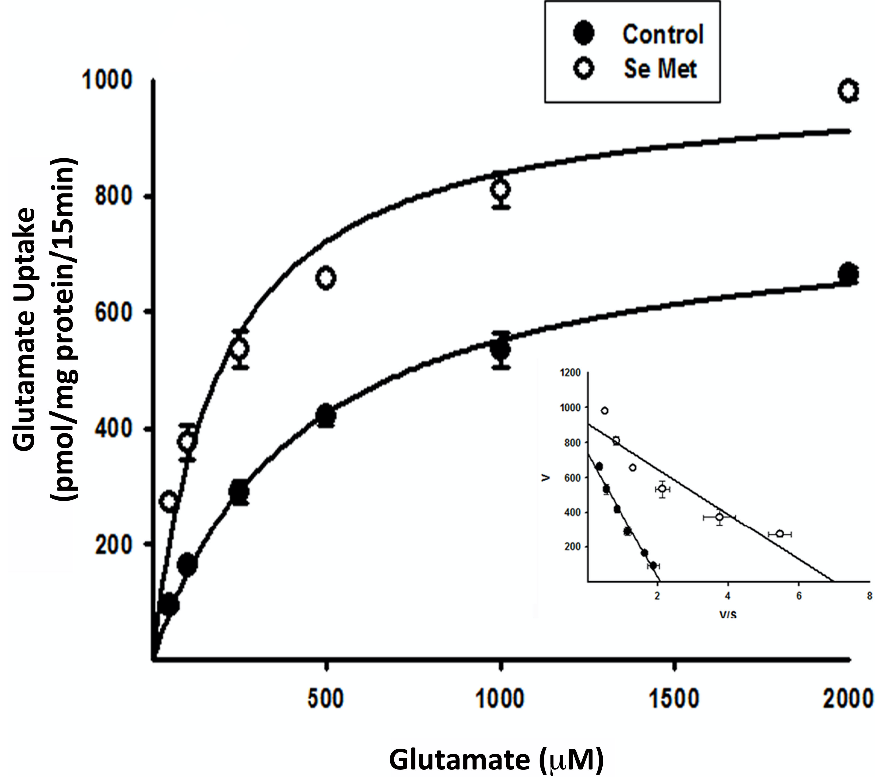
Figure 6. Kinetic analysis of system xc- activity in the presence or absence of Se-Met in ARPE-19 cells: saturation kinetics of glutamate uptake in ARPE-19 cells cultured for 16 h in the presence or absence of 1 mM selenomethionine (Se-Met) was evaluated by monitoring the uptake of [3H]-glutamate in Na+-free medium with various concentrations of unlabeled glutamate (0–2000 μM). Inset: Eadie–Hofstee plot.